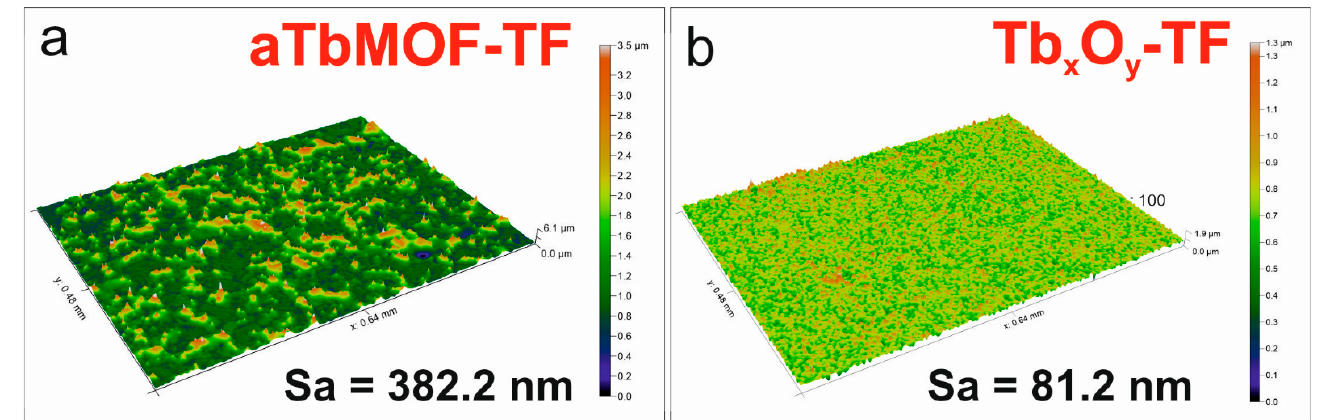
Figure 12. Confocal microscopy (CM) scans of ( a ) aTbMOF-TF and ( b ) Tb x O y -TF thin films in 3D representations with average roughness Sa.